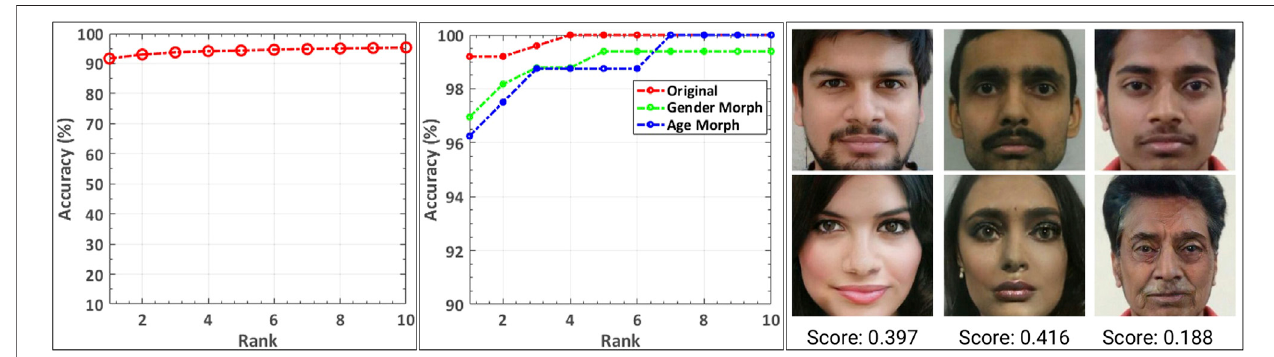
FIGURE 7 | CMC plot for face identi fi cation. (A) Using Snapchat database (left) , (B) Using FaceApp database (middle) , and (C) Gallery and probe images with corresponding match scores obtained using COTS on the images from FaceApp database. The fi rst row contains sample gallery images and the second row contains the corresponding age/gender morph probe image of that subject (right)